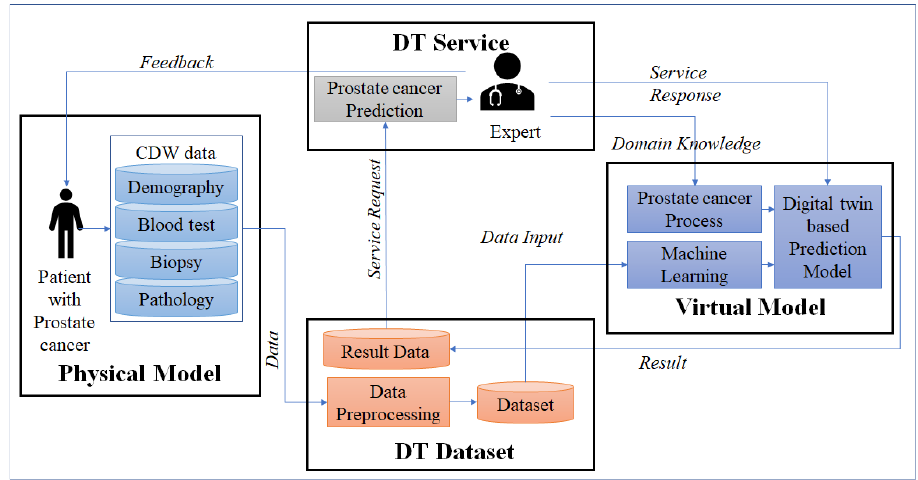
Figure 1. DT framework.